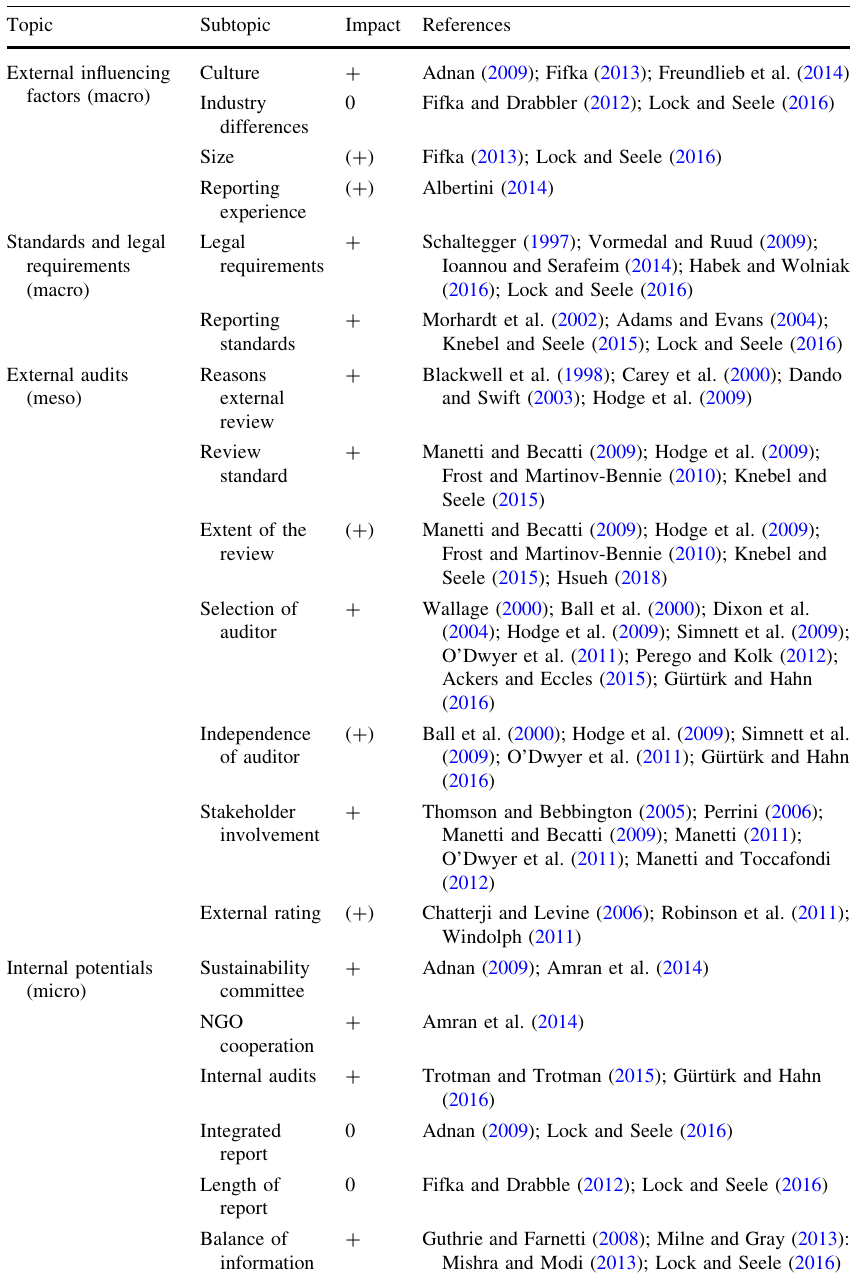
Table 1 Categorization and summary of current findings to counter the credibility